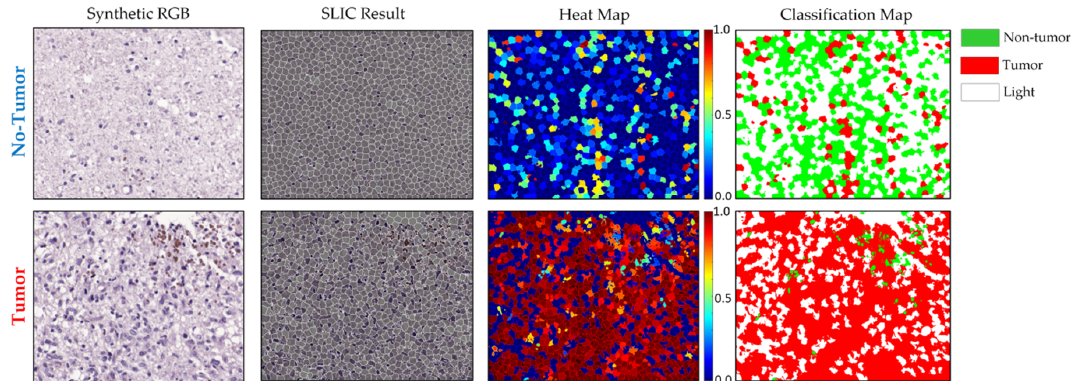
Figure 10. Classification results of the majority voting of superpixels classified by SVM. The top row